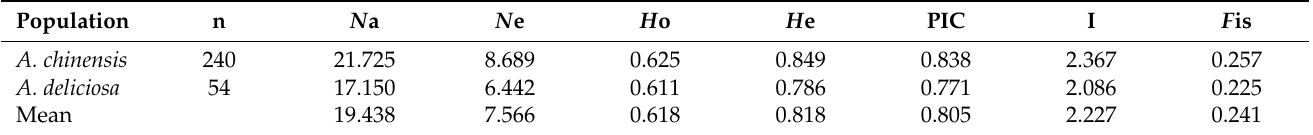
Table 2. Genetic diversity of 40 SSR loci in different variant